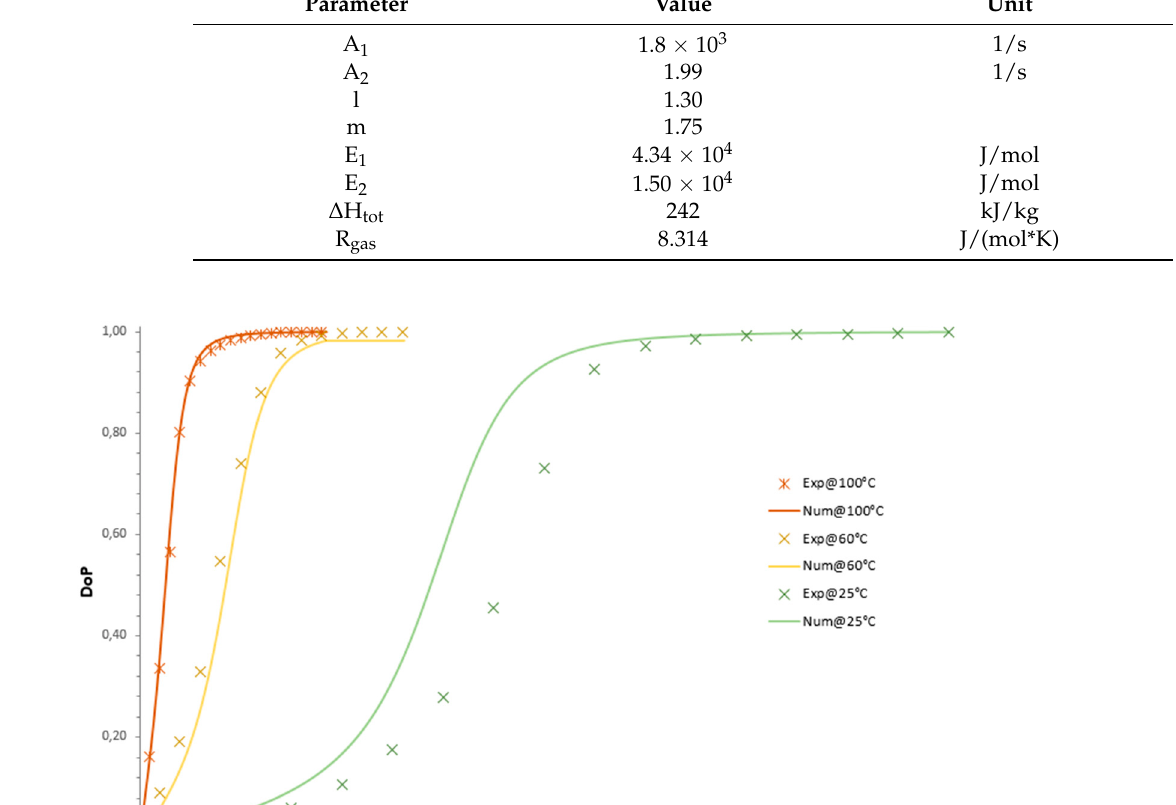
Figure 4. Temperature profile inside the part for the hottest and coldest points and their gradient for the cycle at Tmax equal to 25